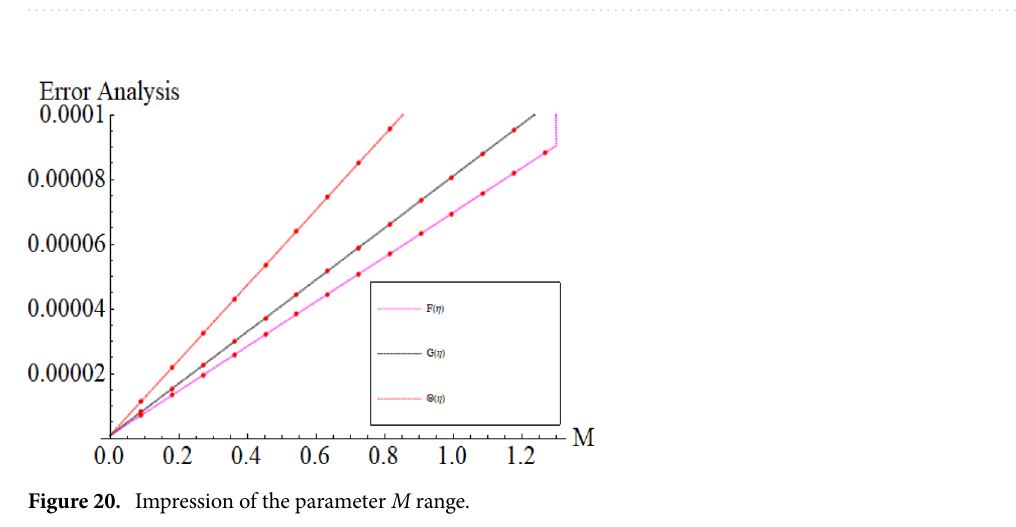
Figure 19. Impression of Θ( η ) amongst a counter rotating disk and cone at three different radial exponents with Re